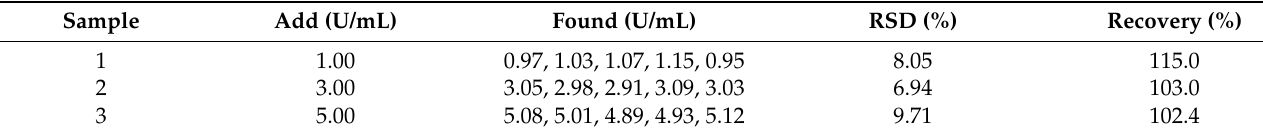
Table 3. The results of analysis of serum